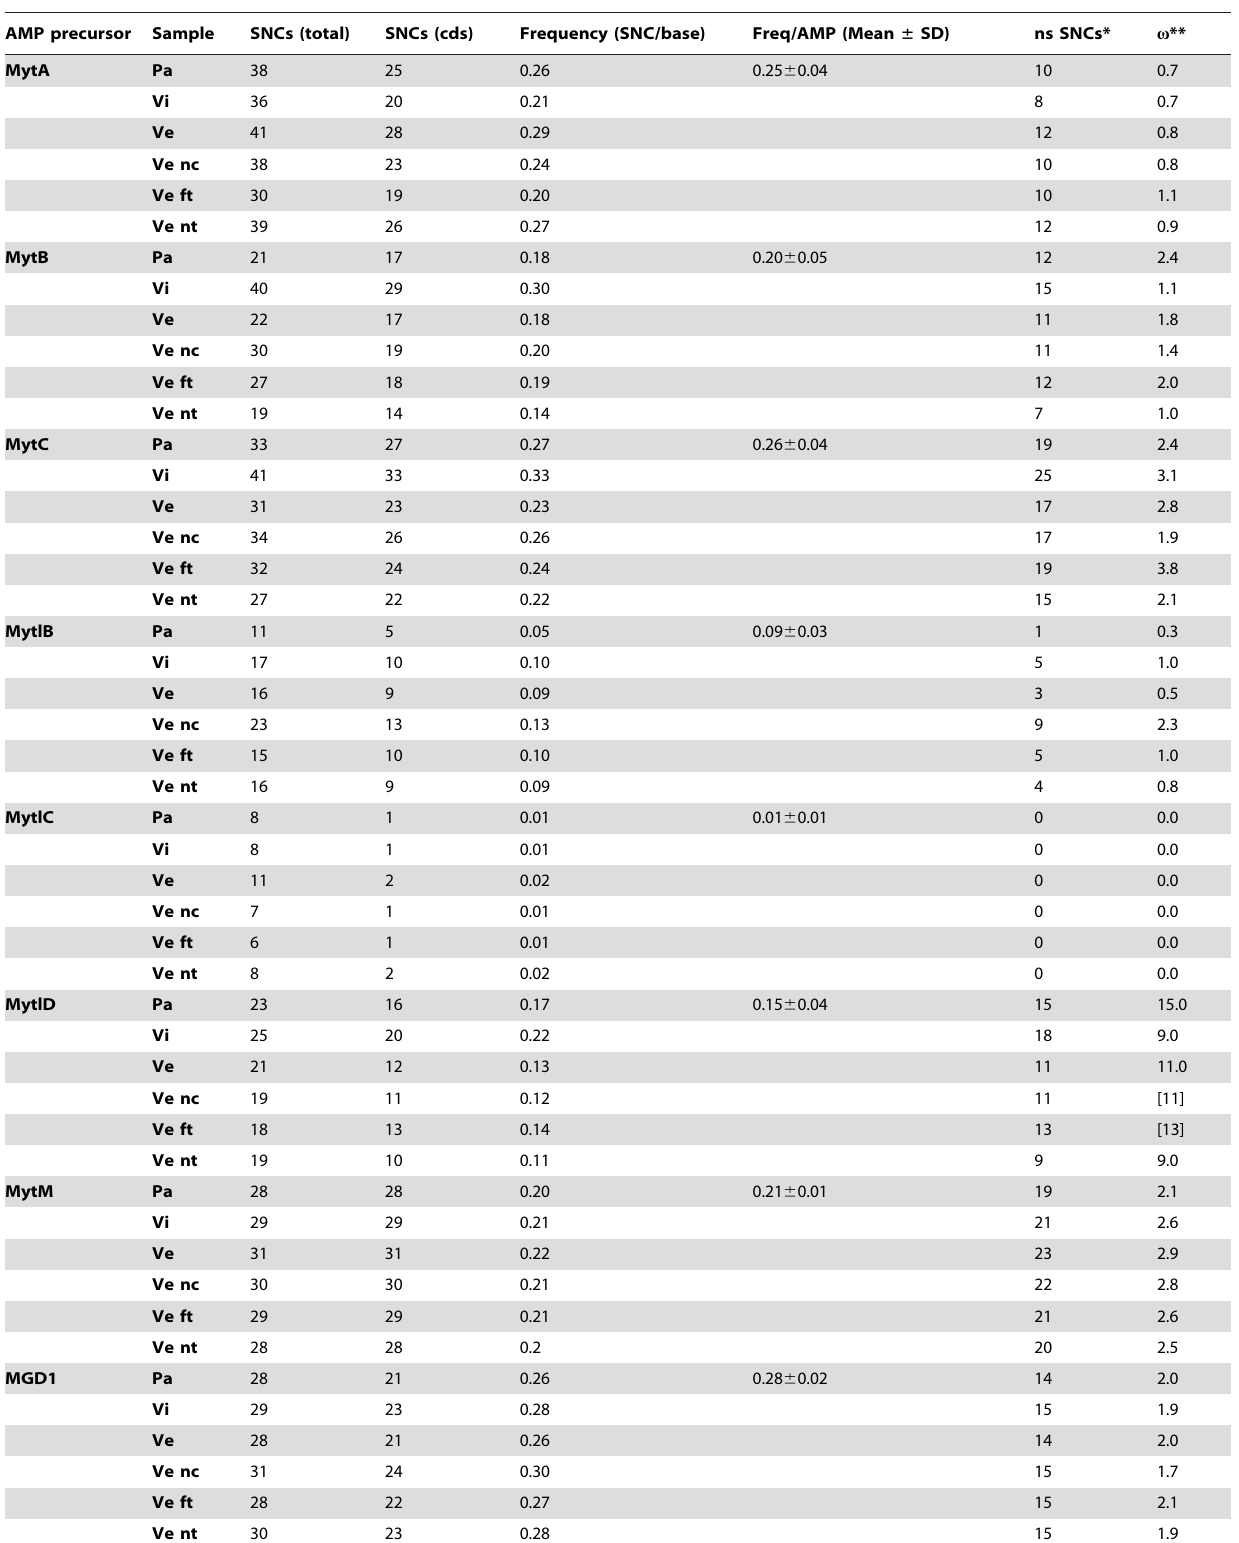
Table 3. Number of SNCs detected in the whole AMP transcript precursor and cds, related frequencies, non-synonymous changes and v